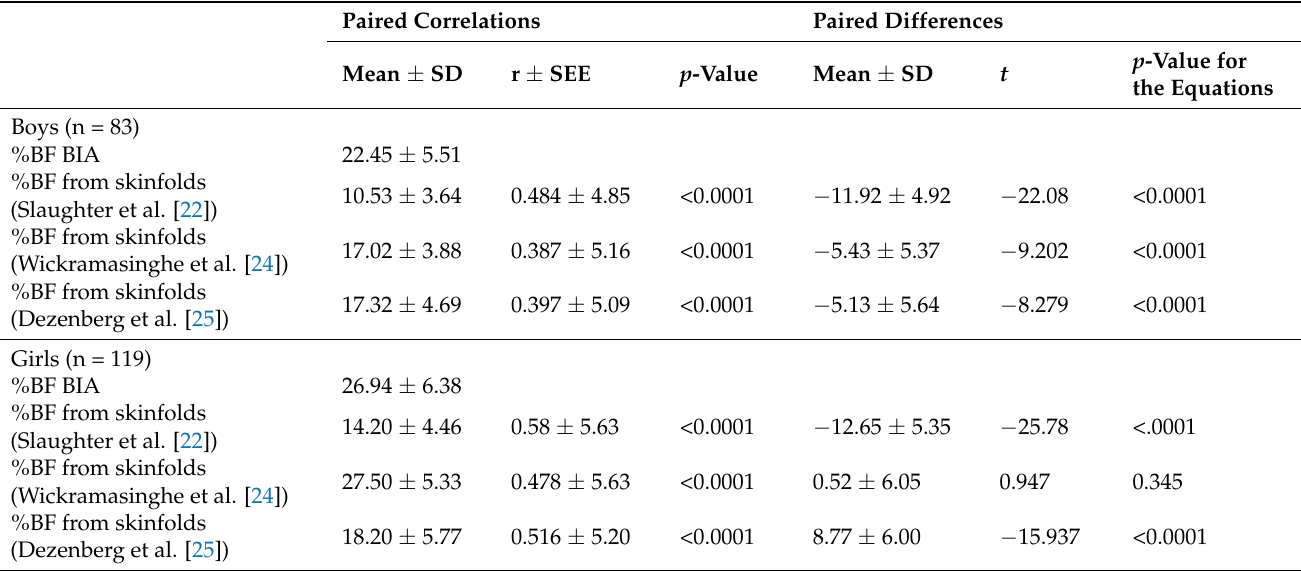
Table 4. Difference between the %BFs obtained from BIA and various skinfold equations.